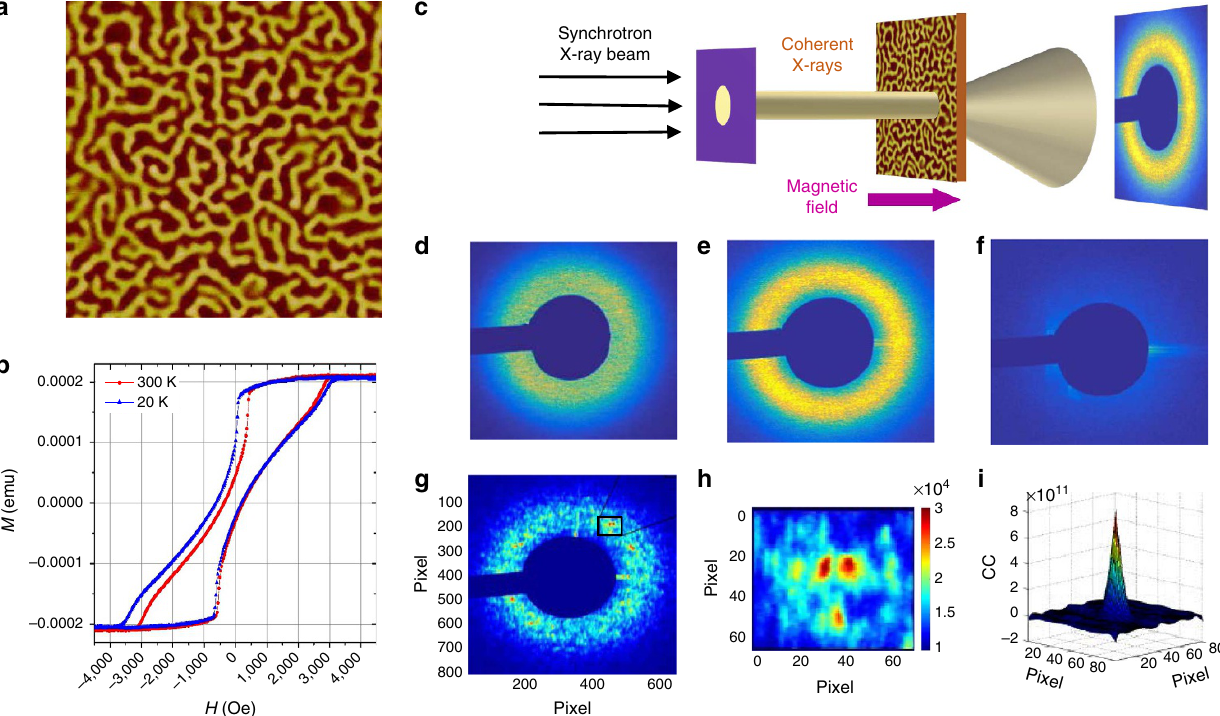
Figure 1 | Imaging of magnetic domain memory in ([Co/Pd]/IrMn) via coherent X-ray scattering and speckle correlation. ( a ) MFM image (5 (cid:2) 5 m m 2 ) of the magnetic domains in the film at remanence at 300K. ( b ) Magnetization loops M ( H ) collected via VSM at 300K and at 20K after FC under a þ 10kOe field, showing a biasing effect. ( c ) Layout of the CXRMS experiment. ( d – f ) CXRMS patterns as collected at the Co– L 3 edge (780eV) on a field- cooled film at 20K and at different field values on the ascending branch of the magnetization curve: ( d ) near nucleation ( H ¼ (cid:3) 200Oe), ( e ) near the coercive point ( H ¼ þ 500Oe) and ( f ) at saturation ( H ¼ þ 4,000Oe). ( g ) Magnetic speckle pattern obtained after extracting the coherent scattering signal and removing the incoherent scattering signal from a CXRMS pattern. ( h ) Zoomed-in view of the speckle spots seen in the selected area of ( g ). The colour bar shows actual number of counts on the detector. ( i ) Typical correlation pattern A (cid:2) B obtained by cross-correlating two speckle patterns A and B such as that in g . The z axis, denoted CC, represents the cross-correlation value. The unit for CC is number of counts squared. The amount of correlation is evaluated by measuring the area under the peak and normalizing it with autocorrelation signals, resulting in the normalized correlation coefficient r